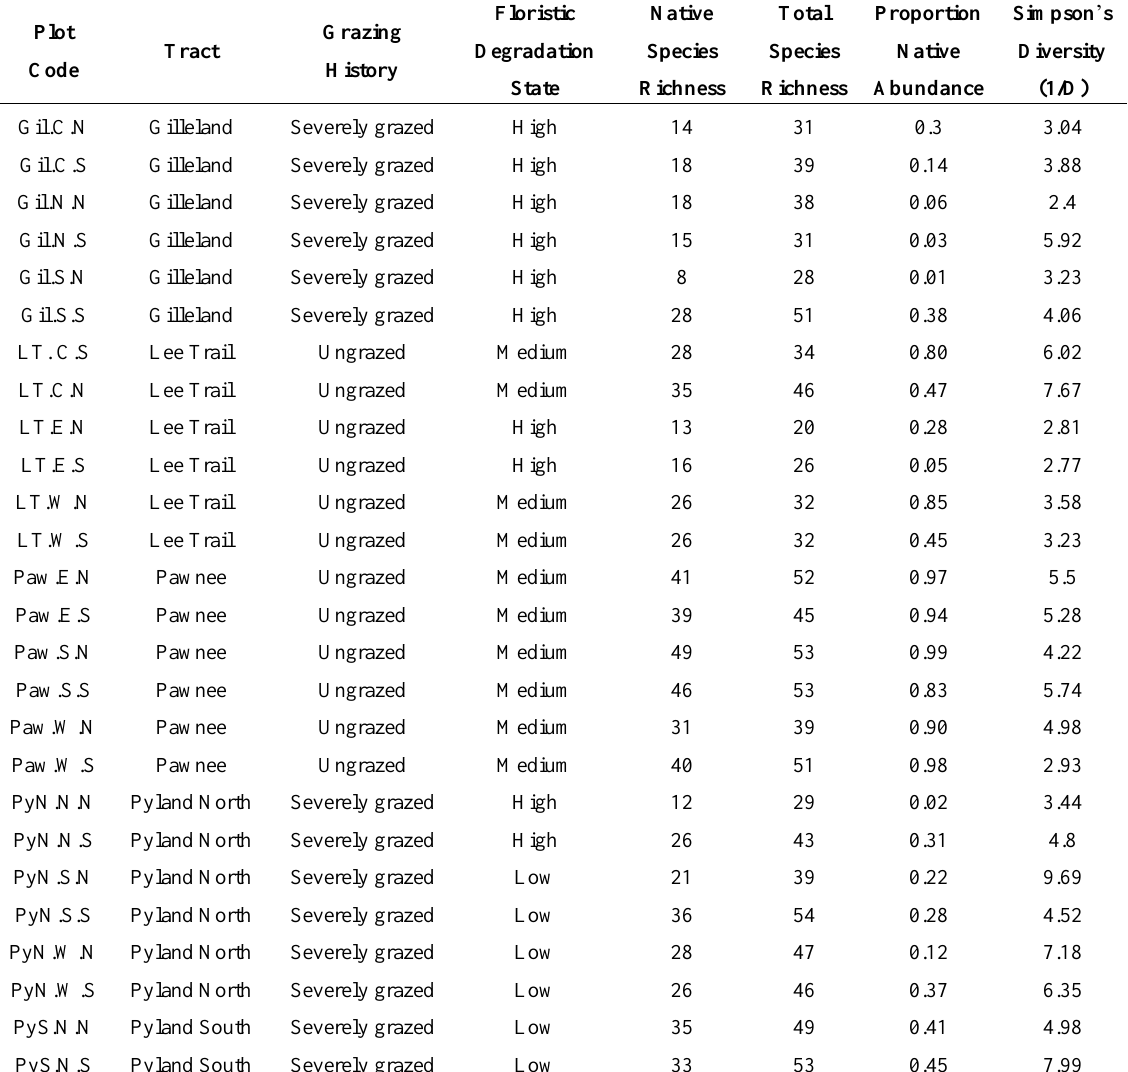
Table A1. Attributes for 54 modified Whittaker plot plant communities used in hierarchical clustering (Figure A1) based on 196 plant species abundance sampled from nine tracts in the Grand River Grasslands of south-central Iowa and north-central Missouri, USA. Plot code represents nomenclature used in Figure A1: “Pasture.Patch.Plot” uses an abbreviation of the pasture name and the first letter of cardinal directions to locate each plot nested within patches [20]. Pasture names correspond with NMDS ordination in Figure 1A of the main text. Native species richness, total species richness, Proportion native abundance, and Simpson’s diversity (1/D) are summarized in Figure 5 in the main